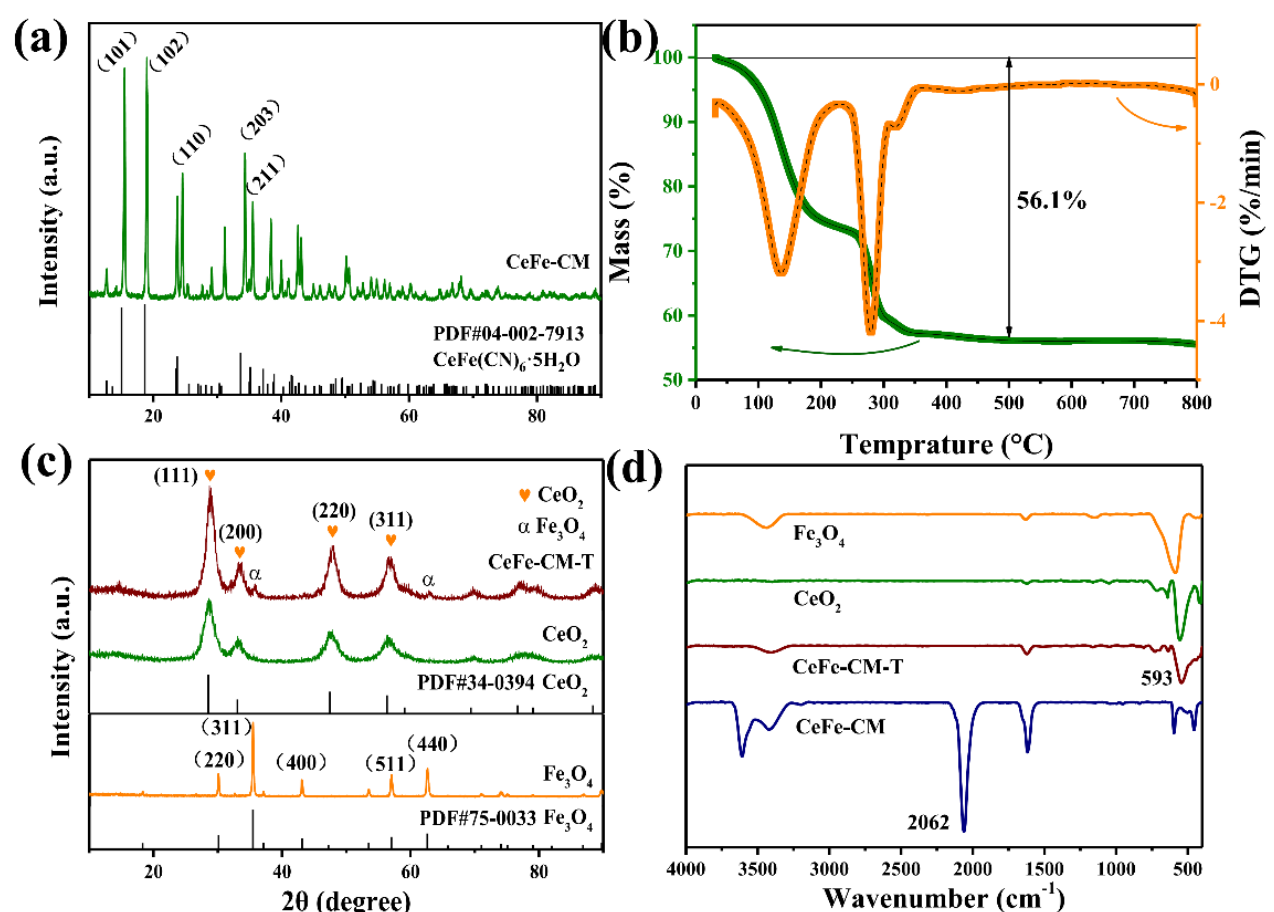
Figure 2. XRD patterns of ( a ) CeFe-CM and ( c ) CeFe-CM-T, CeO 2 , Fe 3 O 4 ; ( b ) TG and DTG curves of CeFe-CM; ( d ) FTIR spectra of CeFe-CM, CeFe-CM-T, CeO 2 , and Fe 3 O 4 .